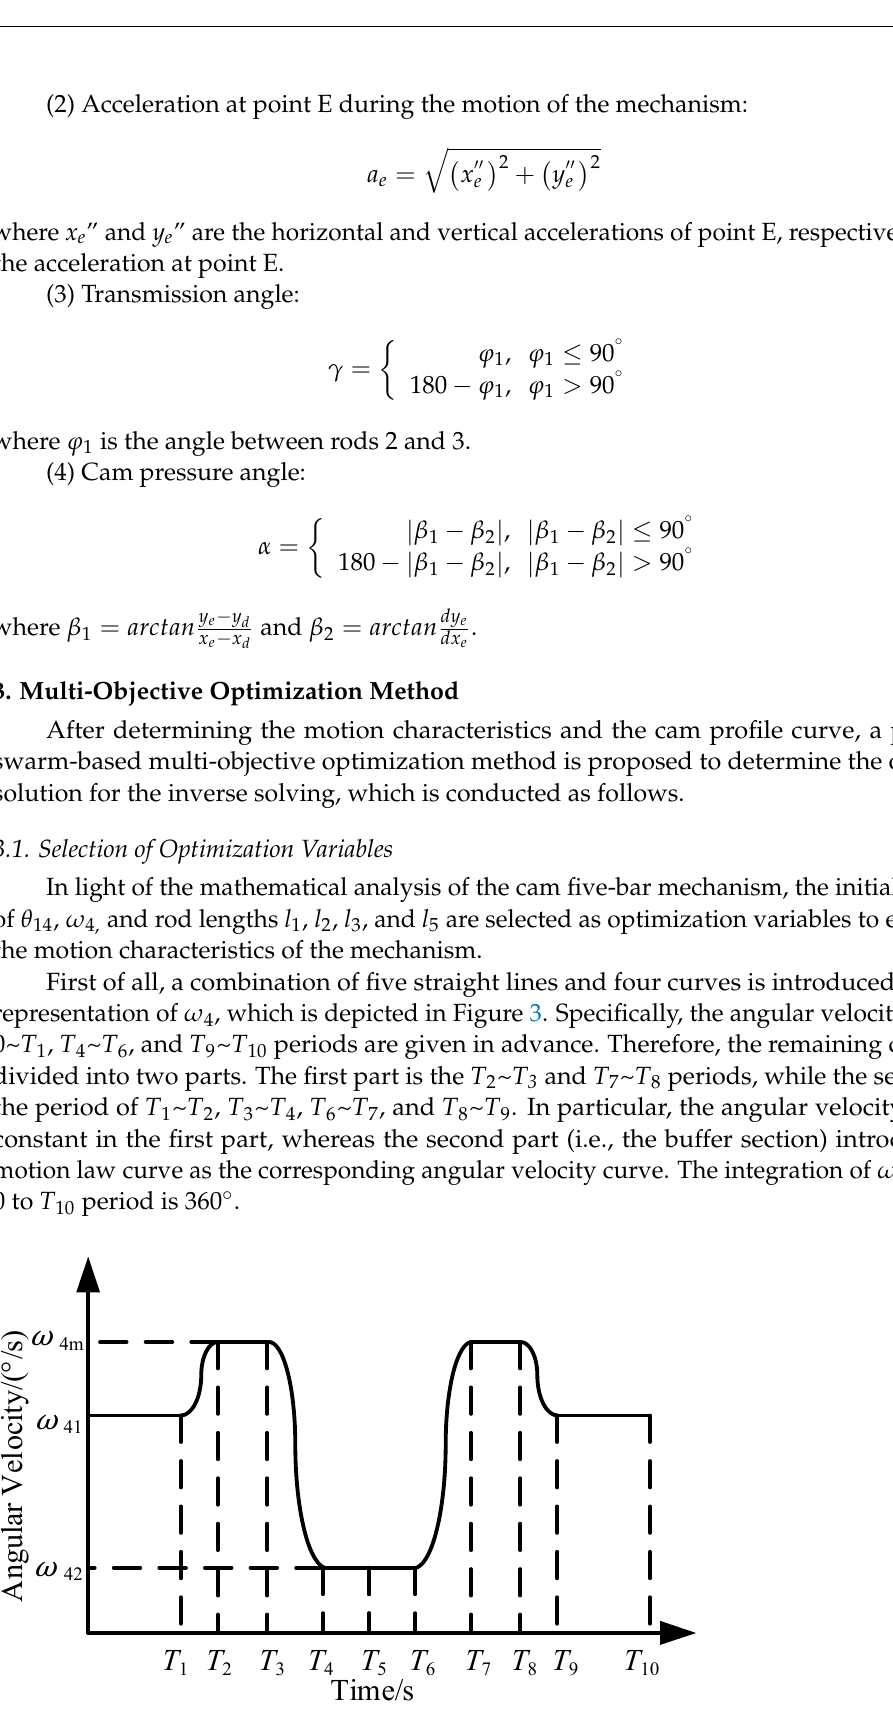
Figure 3. Angular velocity curve of the output Figure 3 . Angular velocity curve of the output component.